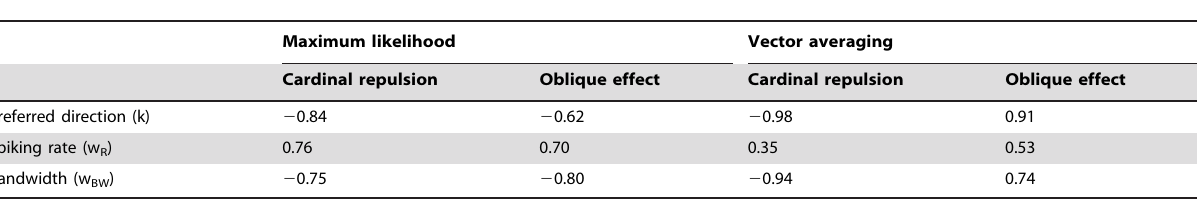
Table 1. Population anisotropy and decoding method on perception.